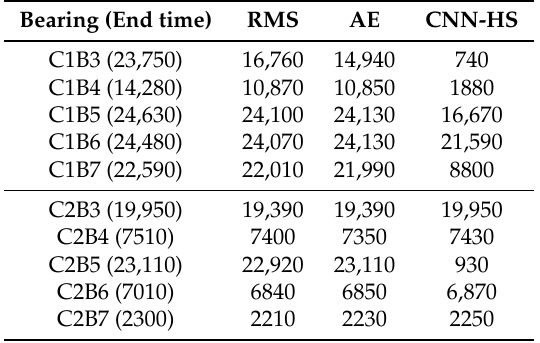
Table 3. Predicted FPT in FEMTO dataset (condition C1 and C2, unit: seconds).